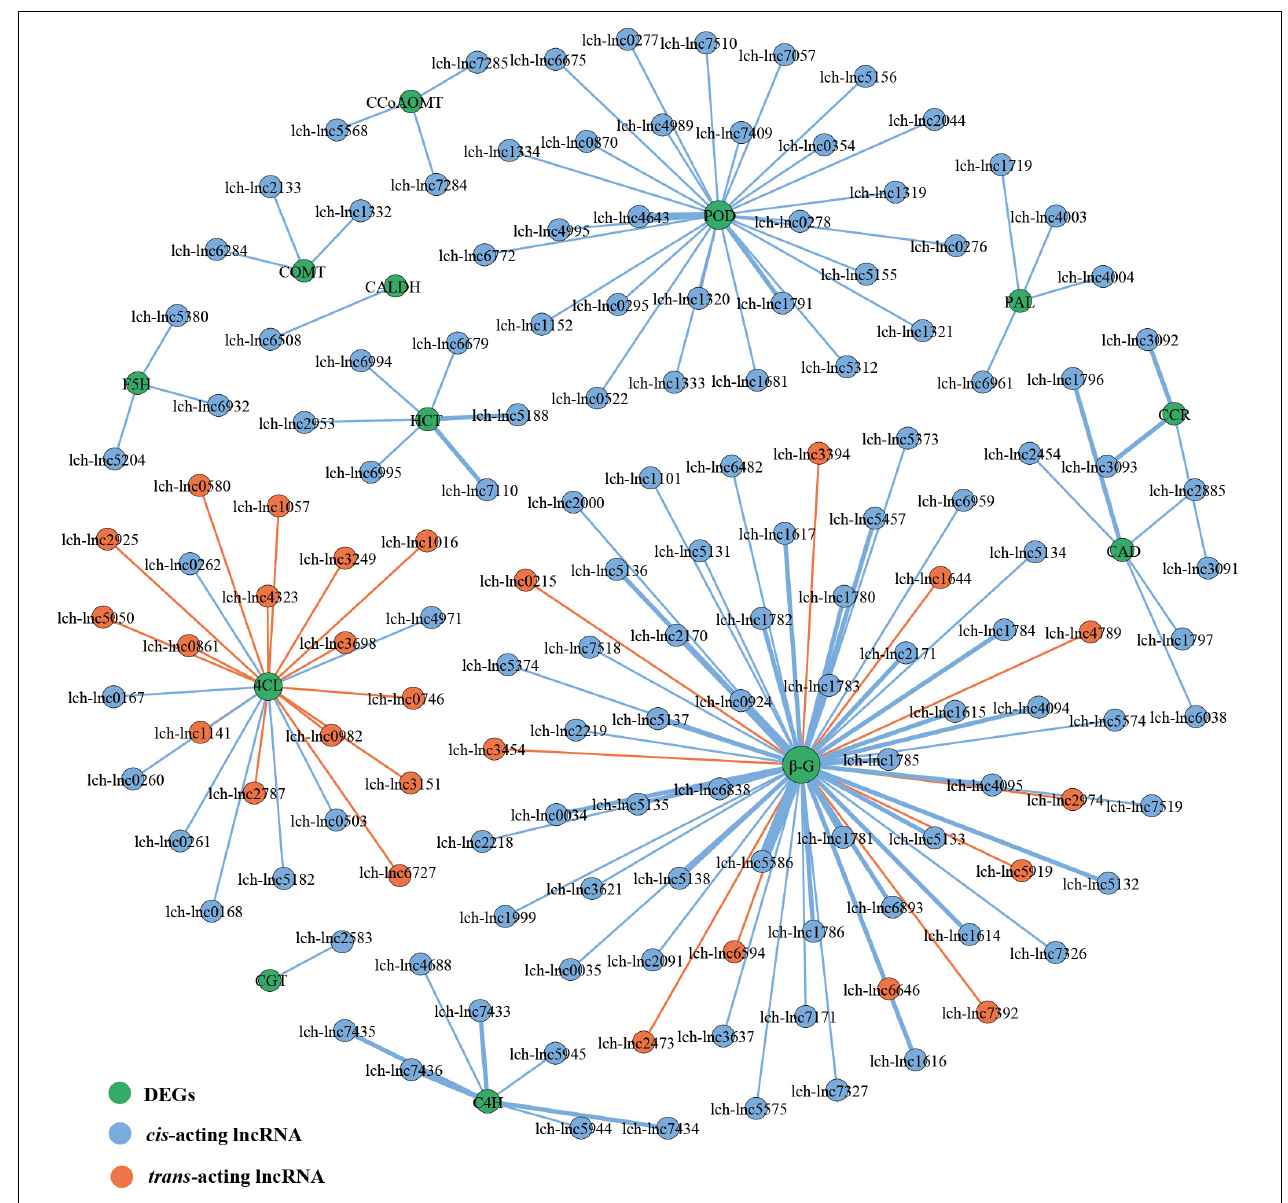
FIGURE 6 | lncRNAs-DEGs regulatory network of phenylpropanoid biosynthesis pathway. The size of the dot represents the number of DEGs: the larger the dot, the more DEGs. The wider the edge, the more DEGs are targeted by lncRNAs.